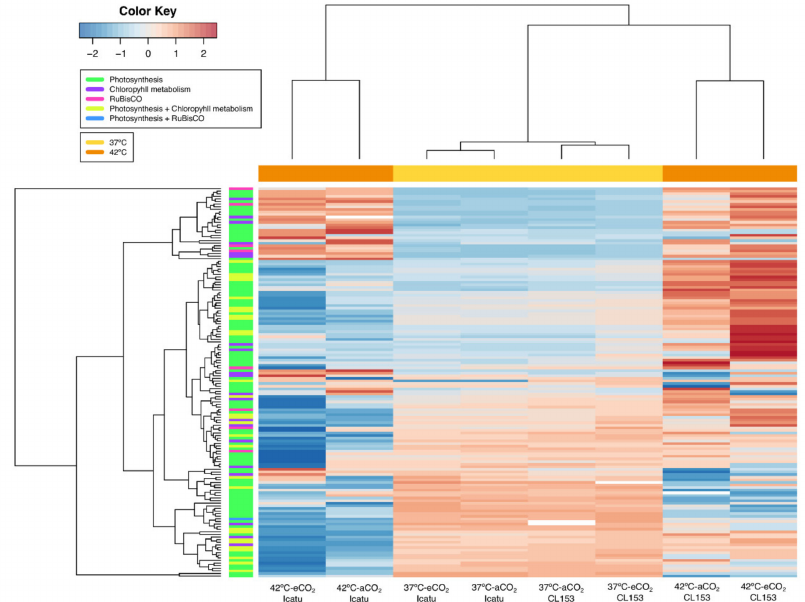
Figure 7. Heatmap and dendrograms of the normalized log 2 fold change (FC) of photosynthesis-related significant differentially expressed genes (DEGs) of Icatu and CL153 plants as a response to 37/28 ◦ C (37 ◦ C) and 42/30 ◦ C (42 ◦ C) and grown in 380 µ L L − 1 aCO 2 or 700 µ L L − 1 eCO 2 . DEGs presented here are annotated with the gene ontology (GO) terms “photosynthesis”, “chlorophyll metabolism process”, and “RuBisCO”, according to the functional annotation of the Coffea canephora genome. The plotted values were scaled by row for improved visualization. Hot colors represent up-regulated DEGs, and cold colors represent down-regulated DEGs. Column color labels group comparisons by temperature treatment, while row color labels group genes by GO